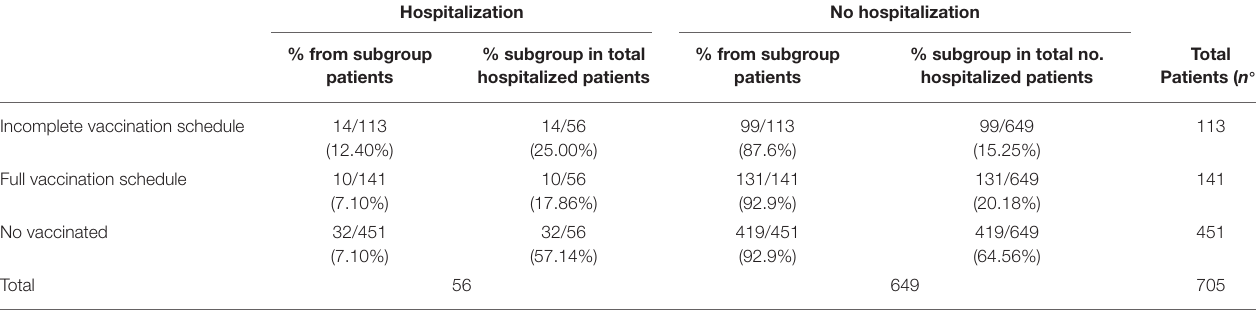
TABLE 5 | Relationship between vaccination schedule (incomplete, full, or unvaccinated) and hospitalization of patients infected with COVID-19 in the second